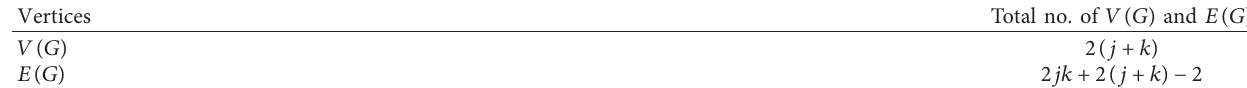
Table 3: Number of vertices of different degrees of the Indu-Bala graph.